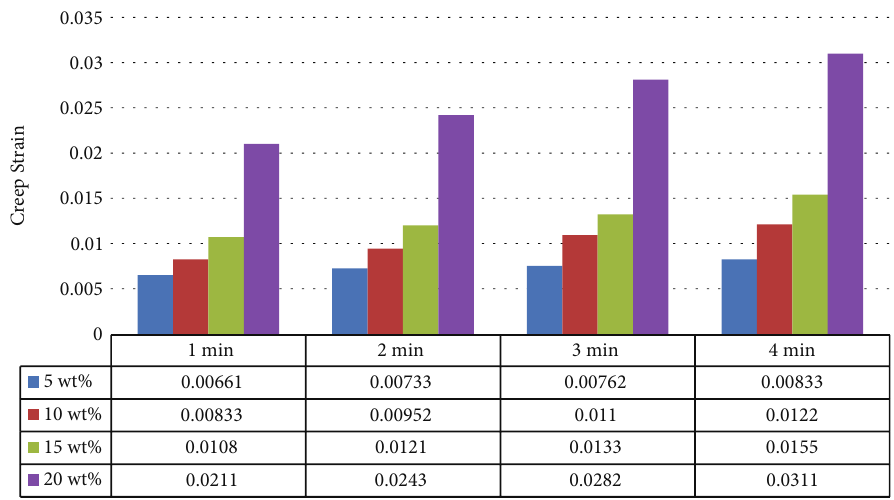
Figure 7: Strain values of Epoxy – DPF composites for di ff erent ratios of DPF (i.e., 5, 10, 15, and 20wt%) with constant applied load of 25N for di ff erent strain times (i.e., 1, 2, 3, and 4